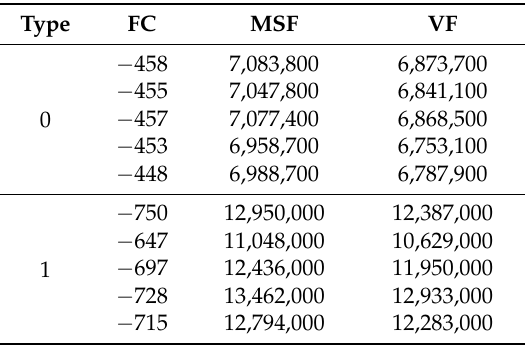
Table 3. The partial data of the frequency-domain